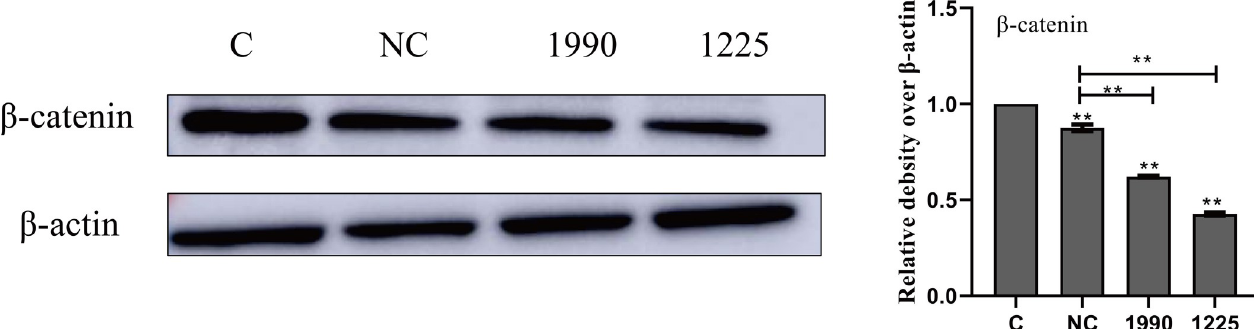
Fig 3. Effect of siRNA on the expression of β -catenin in BMECs. C is negative control group; NC is NC-siRNA group; 1225 is 1225- β -catenin -siRNA group; 1990 is 1990- β -catenin-siRNA group. Western blotting was used to determine the relative levels of β -catenin. β -actin was used as a control. Data are expressed as mean ± SD of 3 independent experiments; � represents 0.01 < P < 0.05 and �� represents P < 0.01.